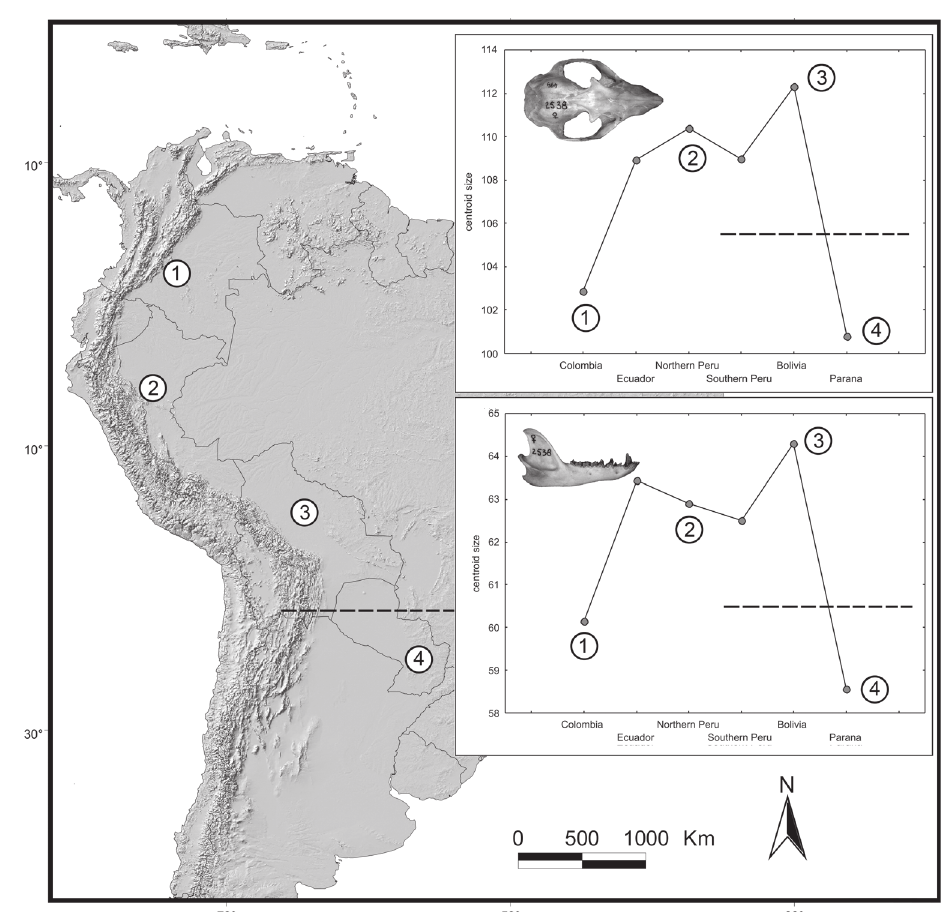
Figure 5. Clinal variation in size of the skull and mandible of populations of Caluromys lanatus along the east of the Andes, from Colombia to Bolivia, with a break between Bolivian and Northern Paraguay/Southern Brazil populations, indicated by the dashed line. Numbers in the map refer to the same points in the two